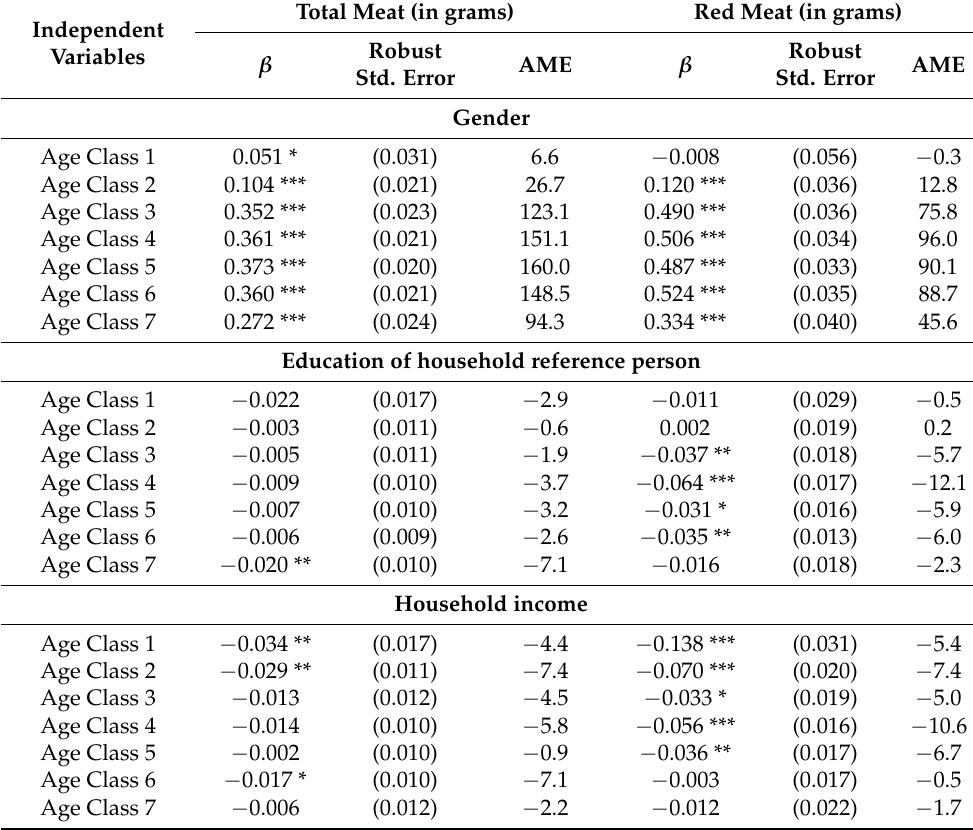
Table A2. Results of the multiple-group regression for the two dependent variables: (1) total meat consumption (in grams) and (2) red meat consumption (in